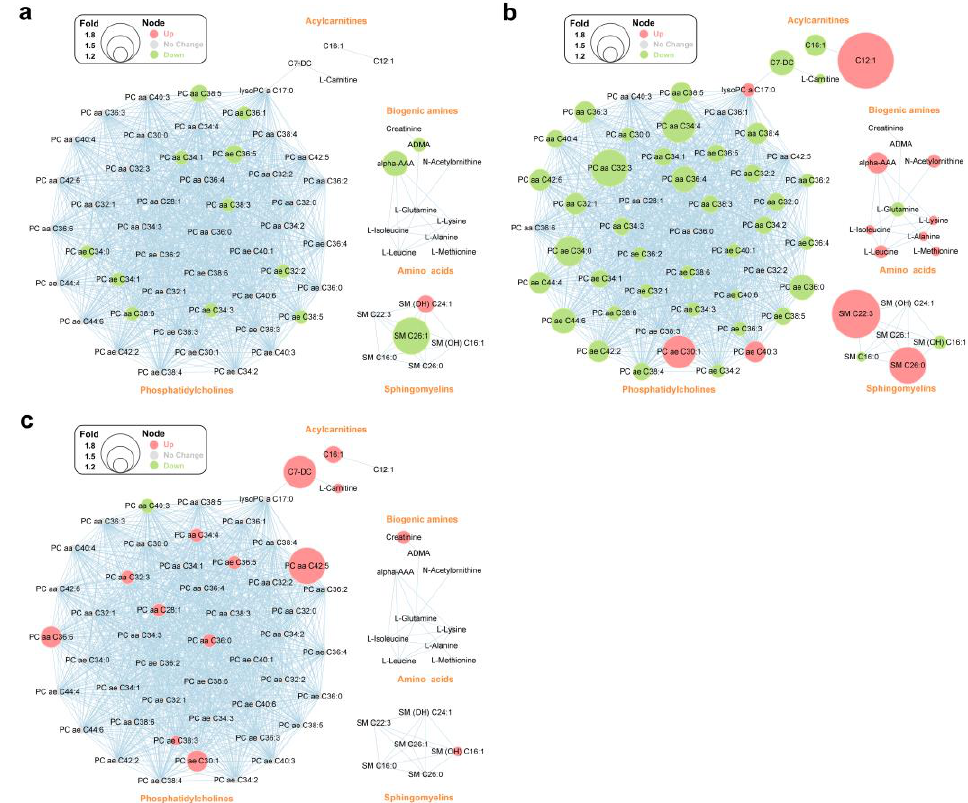
Figure 5. Changes in metabolic patterns of disease progressors compared to non-progressors in the three disease groups. MetaMapp metabolite networks of 67 metabolites altered in DMN ( a ), HTN ( b ), and PKD ( c ), with nodes representing metabolites and edges, indicating chemical relationships. ADMA, asymmetric dimethylarginine; alpha-AAA, L-2-aminoadipic acid; C7-DC, pimelylcarnitine; C12:1, dodecenoylcarnitine; C16:1, hexadecenoylcarnitine; PC aa: diacyl-phosphatidylcholine; PC ae: acyl-alkyl-phosphatidylcholine.